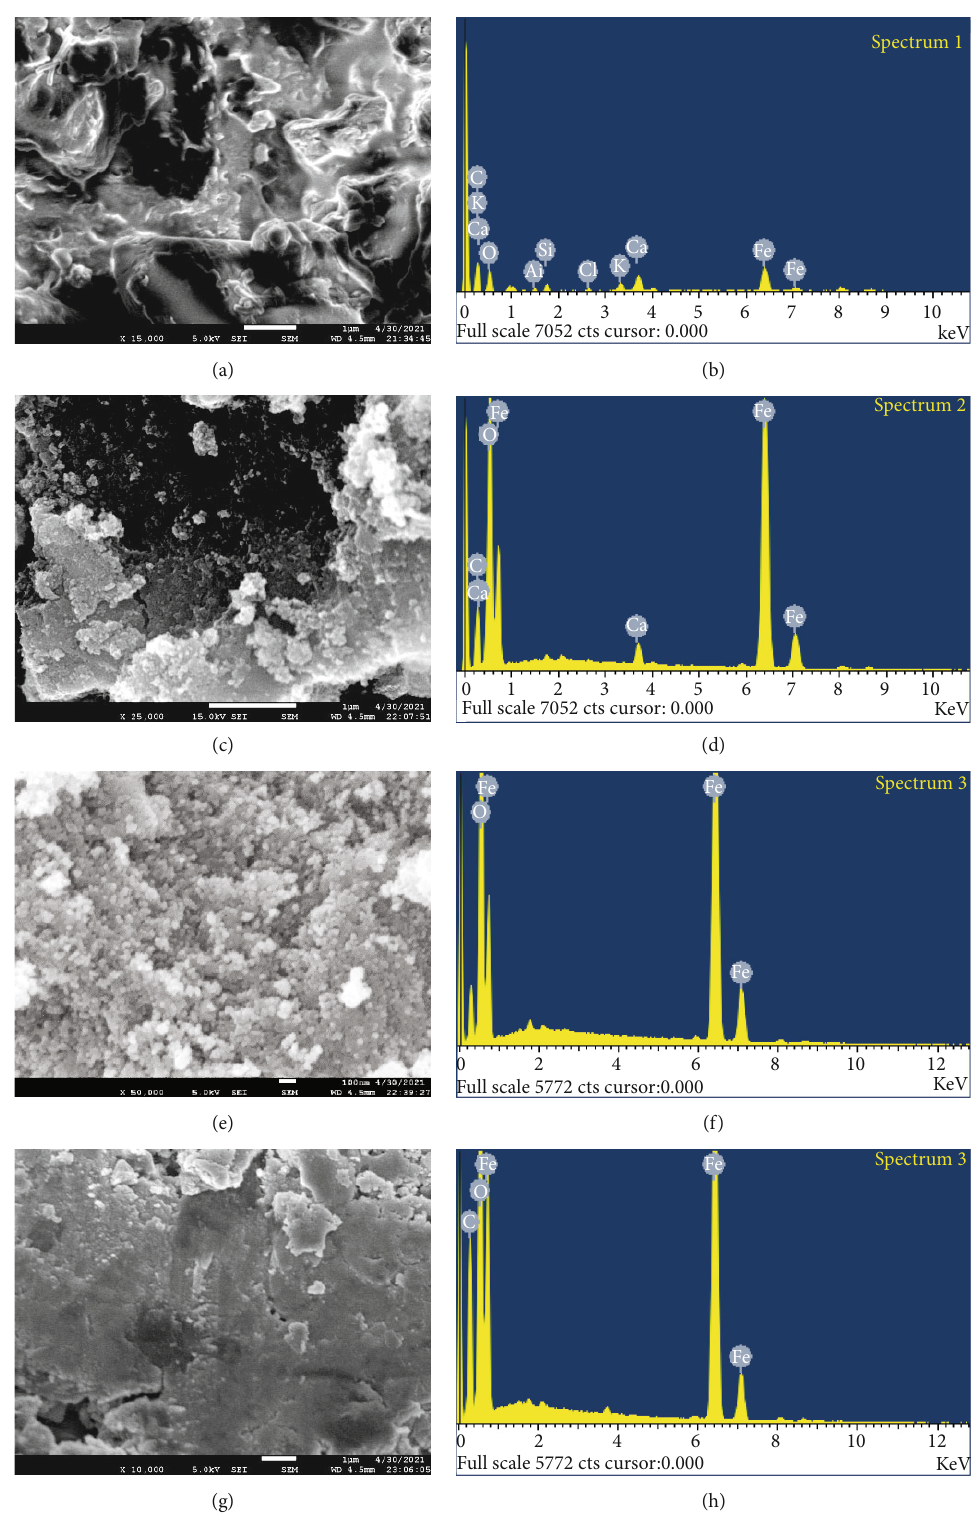
Figure 3: (a) SEM image, (b) EDX analysis of activated Juniperus procera leaves (AJPL), (c) SEM image, (d) EDX analysis of Fe (e) SEM images, (f) EDX analysis of magnetite nanoparticles, (g) SEM image, and (h) EDX analysis of MG adsorption onto Fe